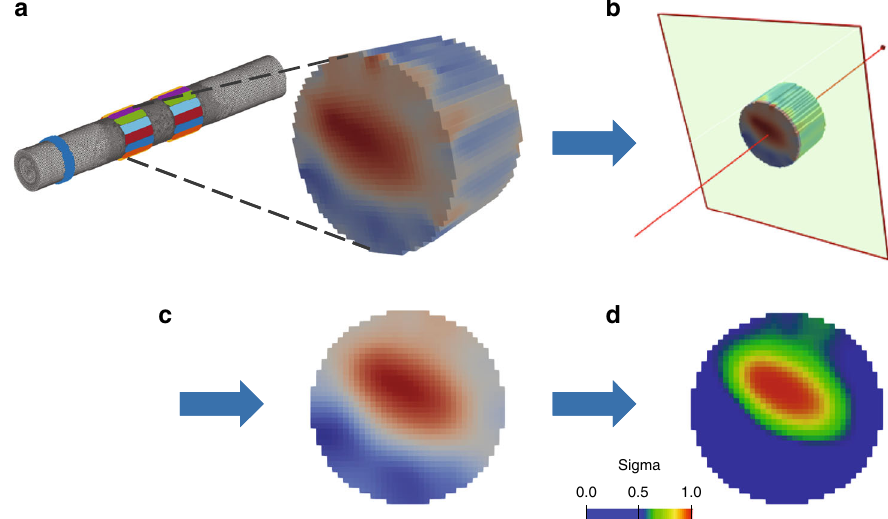
Fig. 6 Post-processing of the reconstructed EIT image. a Nerve subdomain of the 2.63M-elements tetrahedral mesh and zoom in of conductivity variation reconstructed over the coarse version of the electrode ring used for the EIT protocol. b Selection of the slice on the edge of EIT ring, on the side closest to the reference ring. c Slice-based median and mean fi ltering. d The range of values is normalized between 0 and 1, and the rainbow color scale indicates the top 50% of color for each image, i.e., full width at half maximum intensity